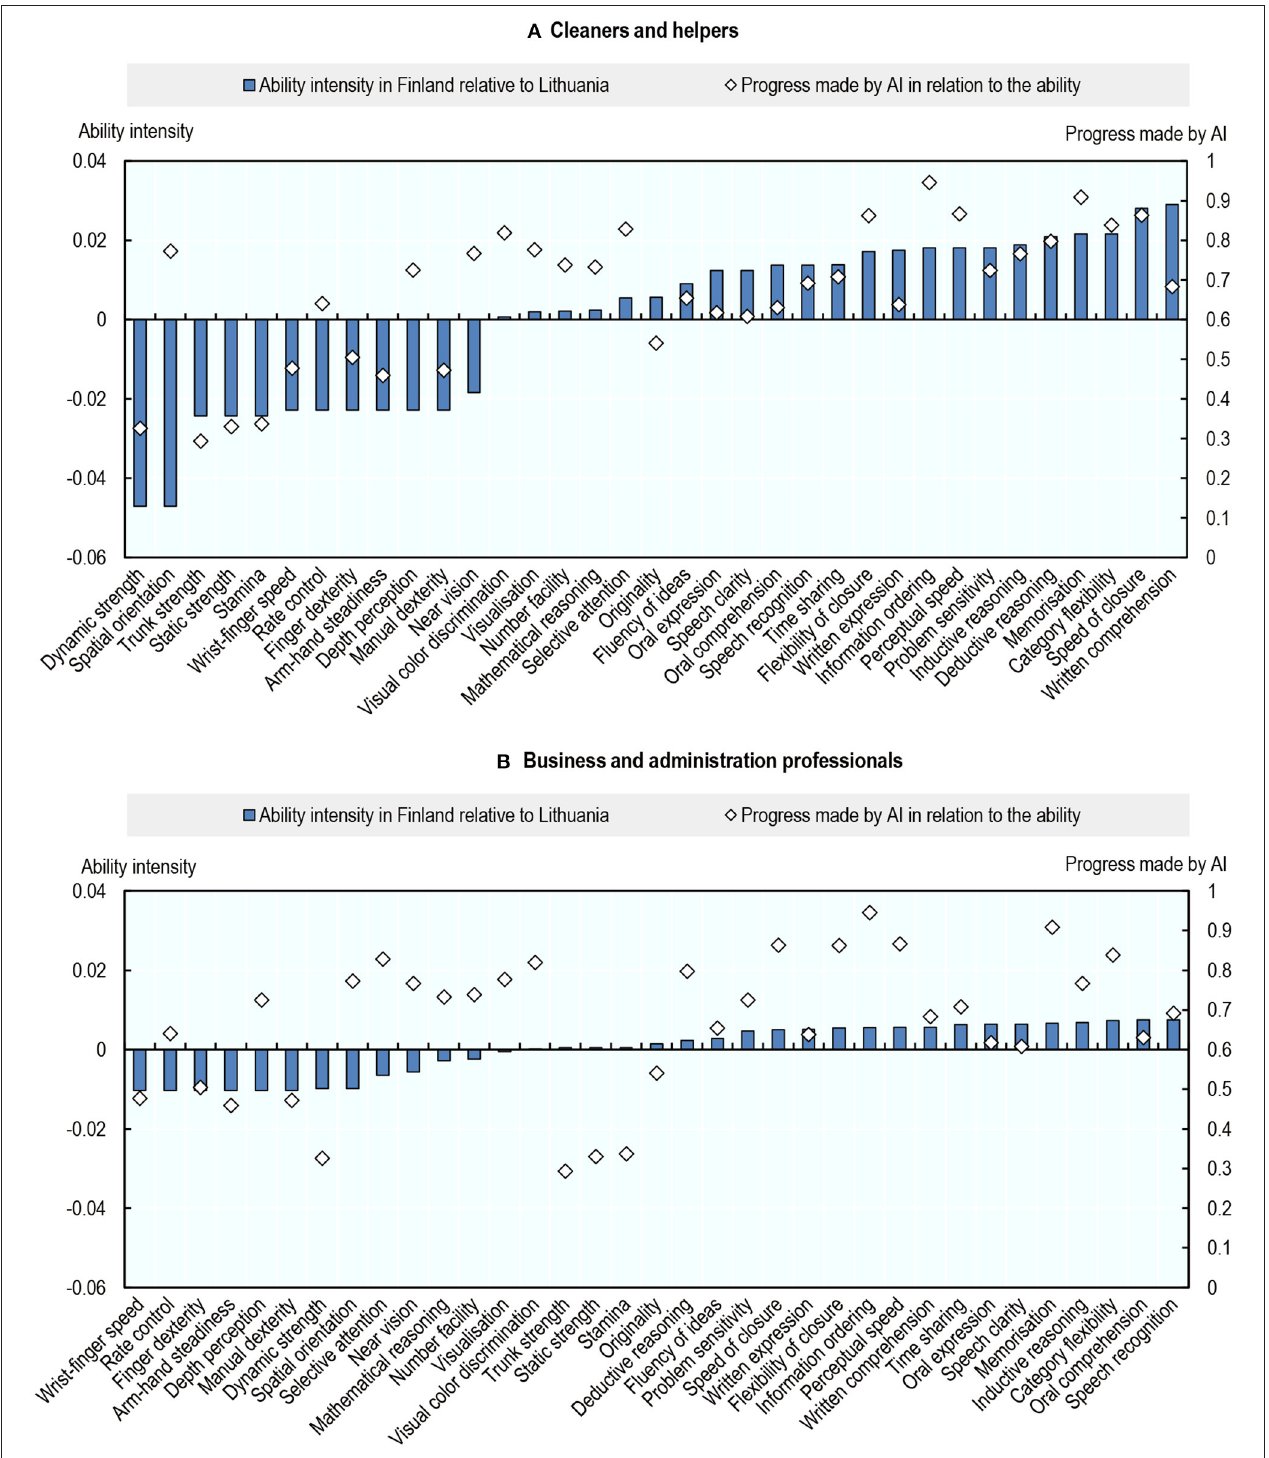
FIGURE 8 | Cross-country differences in occupational AI exposure are caused by differences in the intensity of use of abilities. Intensity of use of an ability in Finland relative to Lithuania and progress made by AI in relation to that ability, 2012. Ability intensity represents the difference in the frequency of the use of an ability among Cleaner and helpers (top) or Business professionals (bottom) between Finland and Lithuania. Authors’ calculations using data from the Programme for the International Assessment of Adult Competencies (PIAAC) and Felten et al. (2019). (A) Cleaners and helpers and (B) Business and administration professionals.